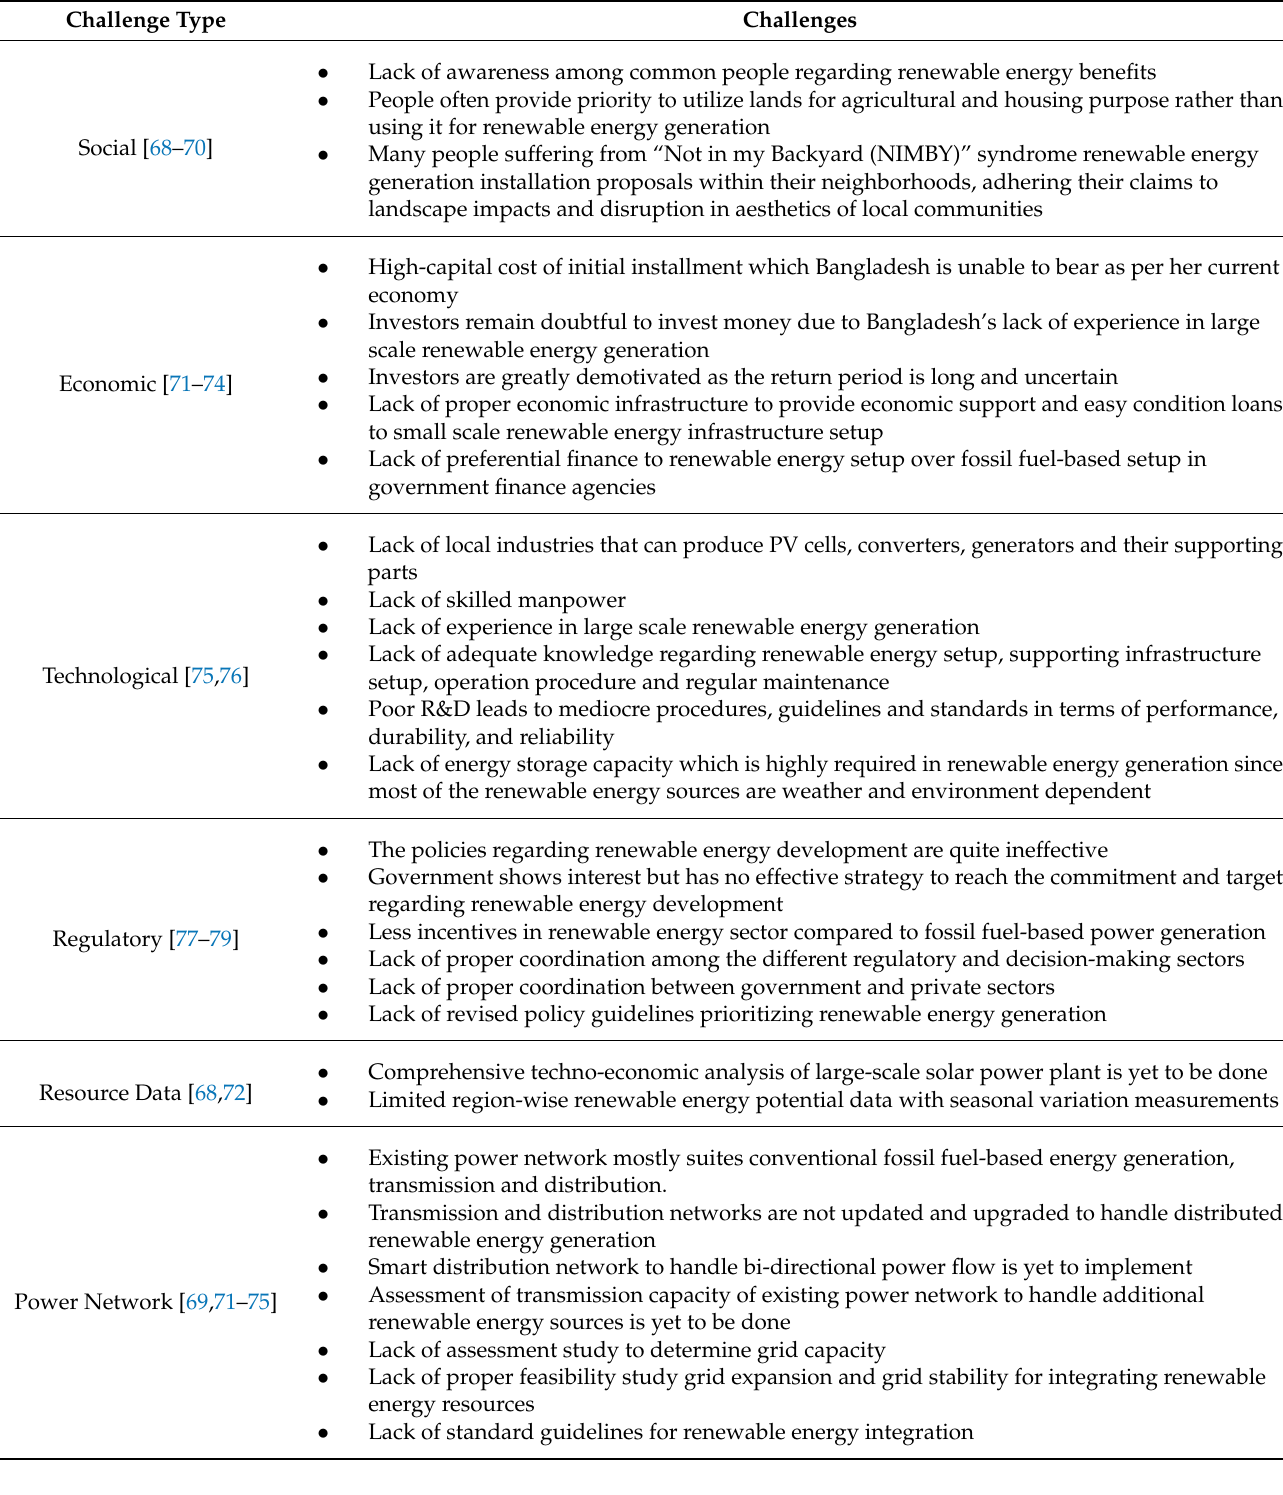
Table 4. Challenges to renewable energy penetration in